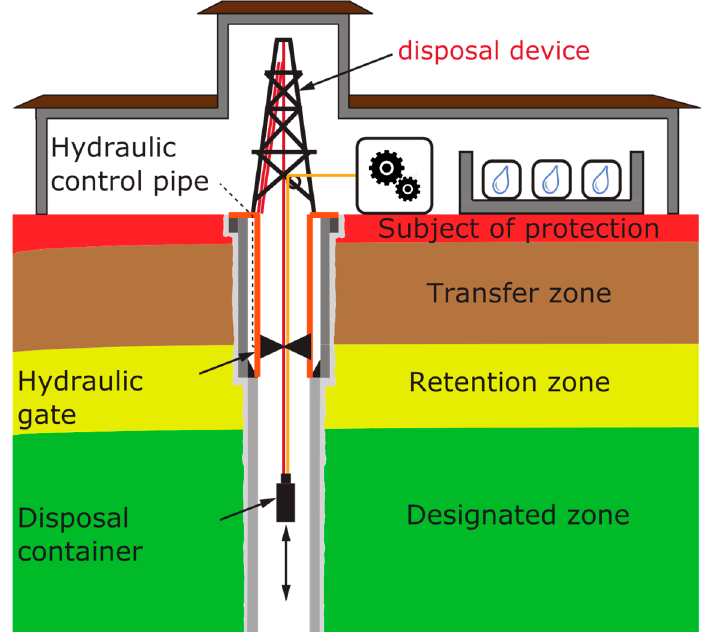
Figure 6. Borehole and disposal operation.